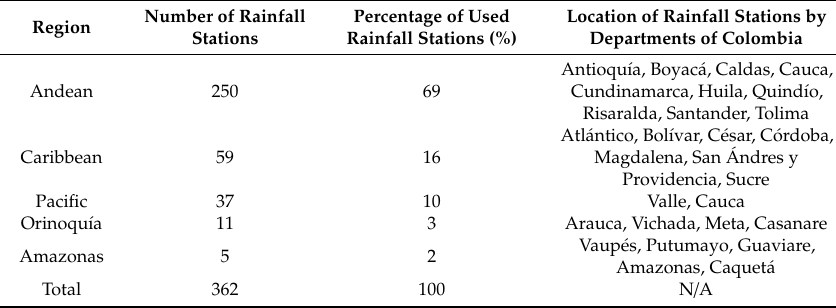
Figure 1. Location of rainfall stations used in the study. Table 1. Number of stations in each